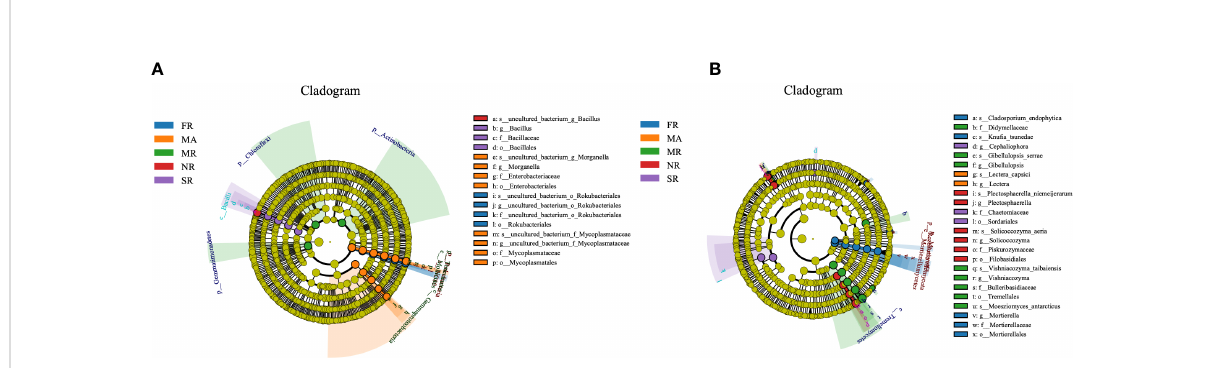
FIGURE 5 Bacterial and fungal under different planting patterns. ( A means bacterial, B means fungal.) In the fi gure, circles from inner to outer layers represent the taxonomic level from phylum to species. The dots on circles represent a term on corresponding taxonomic level. The size of the dots indicates relative abundance. Coloring: Species with no signi fi cant difference are colored yellow. Other colors stand for different groups. Species with certain color means the abundance of this species is the highest in the corresponding group, which helps visualize the most important microbial communities in each